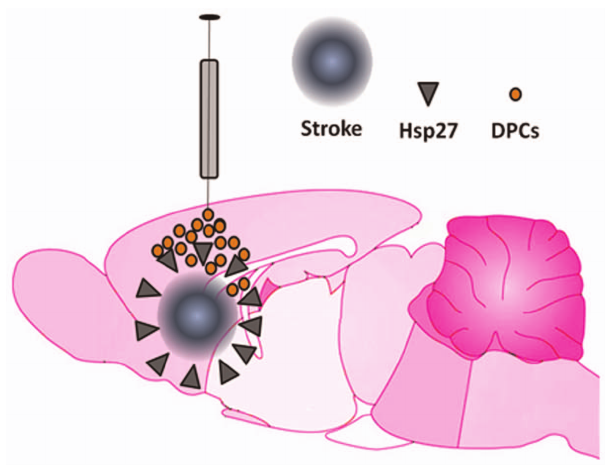
Figure 8. Hsp-27-mediated neuroprotection following DPC transplantation in stroke. Hsp27 appears to be targeted by DPCs for neuroprotection in stroke. Following intracerebral transplantation, DPCs survived in the stroke brain and elevate Hsp27 expression which may afford rescue of the ischemic penumbra proximal, as well as distal from the transplant site. Although the transplanted cells do not migrate far from the transplant site, the anti-oxidative stress protein Hsp27 is able to amplify the